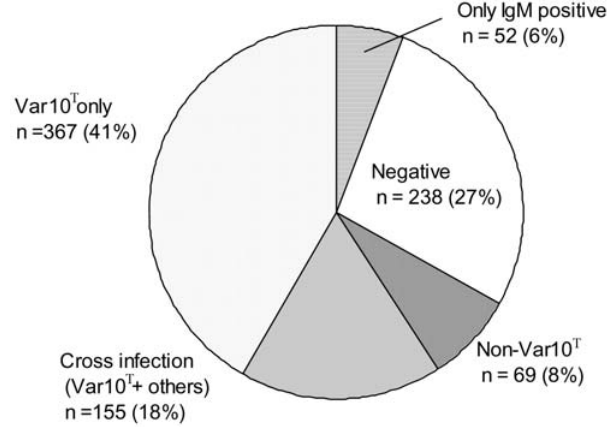
Figure 6. Seroprevalence of ‘‘ Leptospira licerasiae ’’ serovar Varillal in acute febrile patients in Iquitos, Peruvian Amazon (n=881). Var 10= ‘‘Leptospira licerasiae’’ serovar Varillal strain VAR 010 T . Criteria for serological diagnosis of acute Leptospira infection: 1) IgM positive by ELISA in either acute or convalescent sera; 2) Conversion in the microscopic agglutination test (MAT) from negative to positive (1:100 or greater); 3) Single MAT titer of 1:800 or greater; or 4) Four-fold rise in MAT titer.